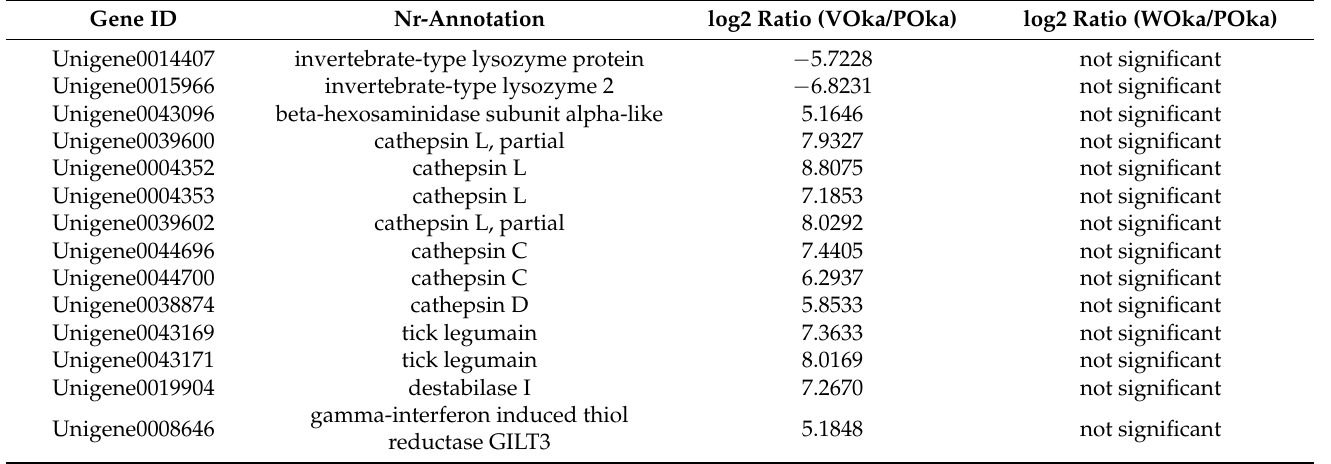
Table 4. DEGs related to lysosome in the lymphoid organ after Vibrio or WSSV